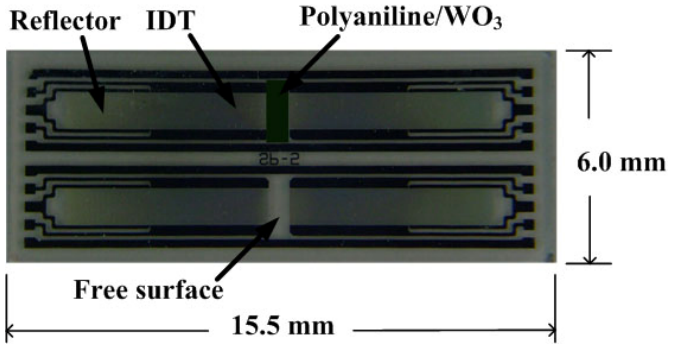
Figure 6. The photograph of a dual-device